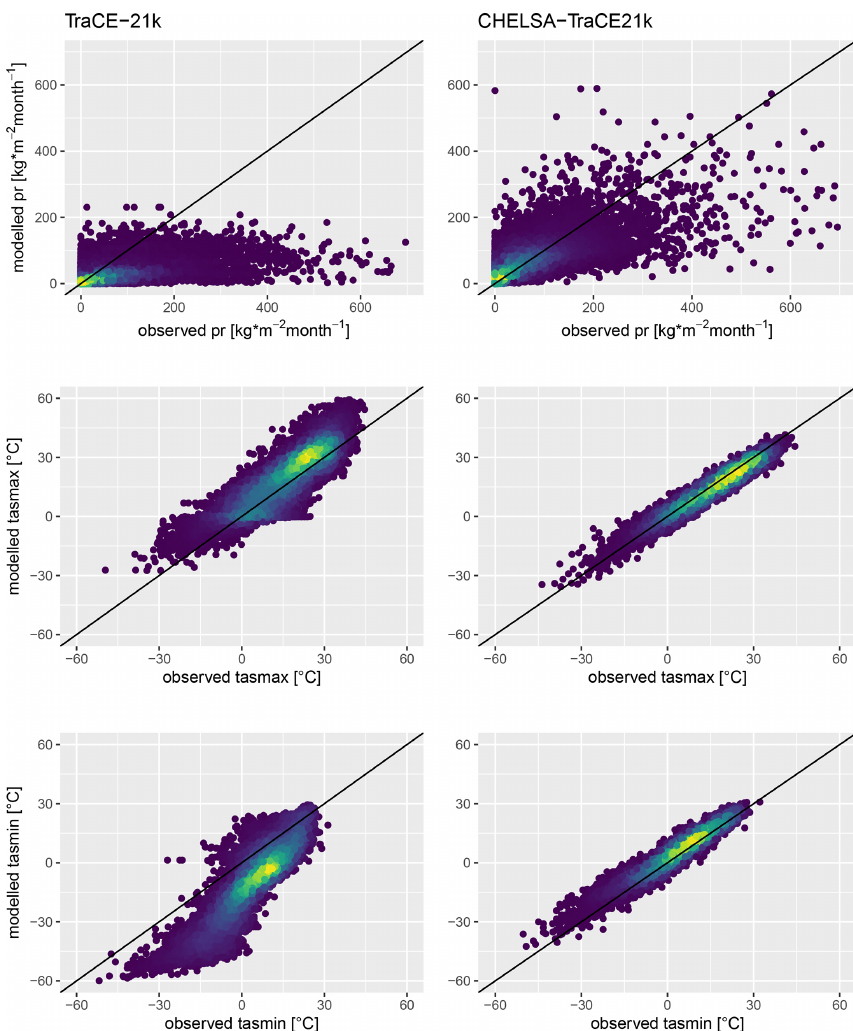
Figure 4. Scatterplots comparing precipitation, maximum, and minimum temperature. Data are aggregated from TraCE-21k and CHELSA- TraCE21k for the 20th-century time period with observational data from the Global Historical Climate Network (GHCN) for the time period